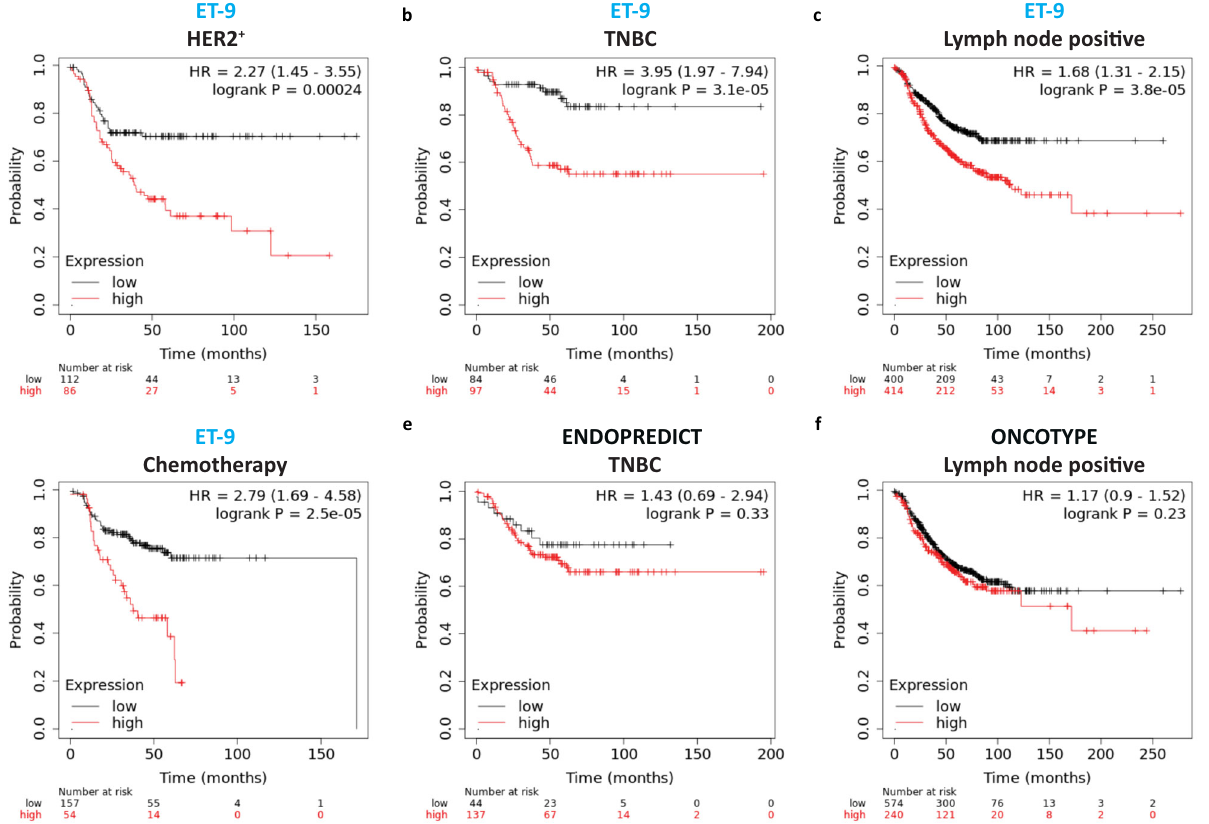
Fig. 5 ET-9 in breast cancer subgroups. The Kaplan-Meier (KM) charts of relapse free survival of human breast cancer generated using Kaplan-Meier plotter [Breast] high risk (red line), low risk (black line). The analysis is carried out by using all probe sets per gene with auto selection of best cut off values, exclusion of biased arrays, and no data censoring and multivariate analysis. The relative hazard ratios (HR) were computed using Cox proportional hazard regression analysis 68 . a KM chart of ET-9 in HER2 + human breast cancer, HR: 2.27 [CI 1.45 – 3.55], p = 2.4e − 4. b KM chart of ET-9 in triple negative breast cancer (TNBC), HR: 3.95 [CI 1.97 – 7.94], p = 3.1e − 5. c KM chart of ET-9 in lymph node positive human breast cancer, HR: 1.68 [CI 1.31 – 2.15], p = 3.8e − 5. d KM chart of ET-9 in breast cancer patients with systemic chemotherapy, HR: 2.79 [CI 1.69 – 4.58], p = 2.5e − 5. e KM chart of 12-gene Endopredict signature in TNBC, HR: 1.43 [CI 0.69 – 2.94], p = 0.33. f KM chart of Oncotype DX in lymph node positive human breast cancer, HR: 1.17 [CI 0.9 – 1.52], p =